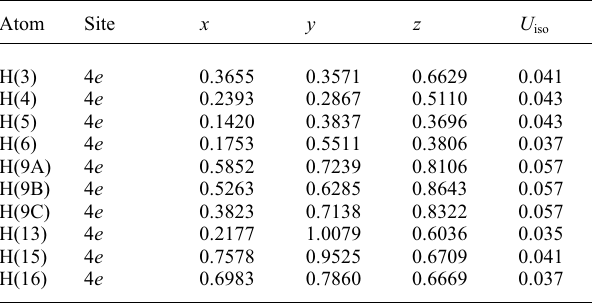
Table 2. Atomic coordinates and displacement parameters (in Å 2 )